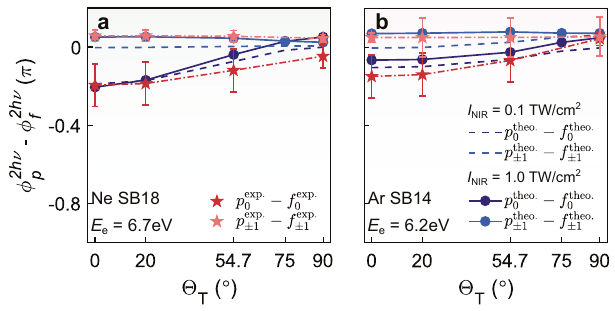
Fig.5|Relativepartial-wave-resolvedphaseshiftbetween p -and f -waves.a The skew-angle-dependent two-photon transition phase shift between p 0 / f 0 and p ±1 / f ±1 inneonatomsatSB18.Thedarkandlightredstarsplotthereconstructed Δ ϕ 2 h ν p deviation.Thebluecirclesanddashedlinesshowthetheoreticallysimulatedresults from the RMT simulation under the NIR intensity of I NIR =1.0TW/cm 2 and I NIR = 0.1TW/cm 2 , respectively. b As a but for the argon